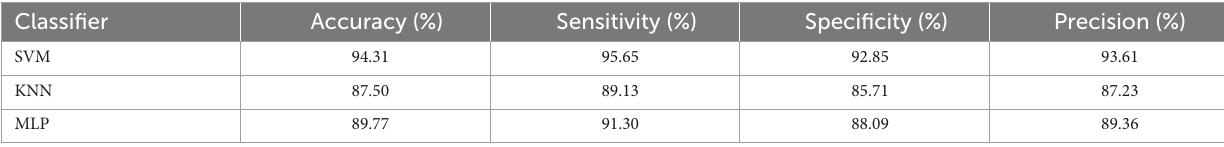
TABLE 5 Classifier performance in percentage, for 10-fold cross validation and combined feature vector.